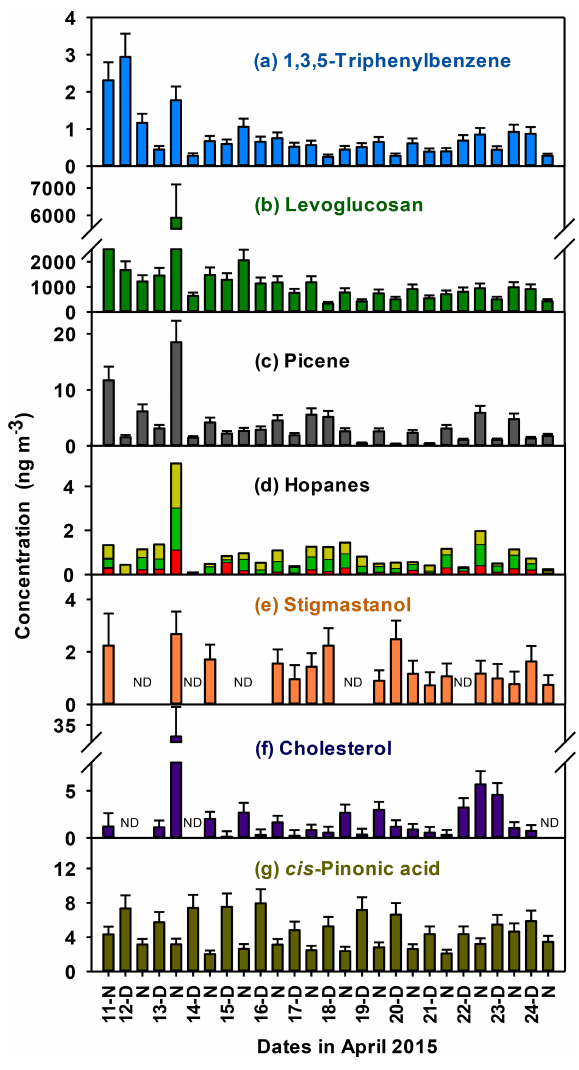
Figure 4. Daytime and nighttime concentrations of (a) 1,3,5- triphenylbenzene, (b) levoglucosan, (c) picene, (d) 17 α (H)- 22,29,30-trisnorhopane in red, 17 β (H)-21 α (H)-30-norhopane in light green, and 17 α (H)-21 β (H)-hopane in yellow, (e) stigmastanol, (f) cholesterol, and (g) cis -pinonic acid in PM 2 . 5 in the Kathmandu Valley, Nepal. Error bars represent analytical uncertainties propa- gated from measurements. Measurements below the instrumental detection limits are marked as